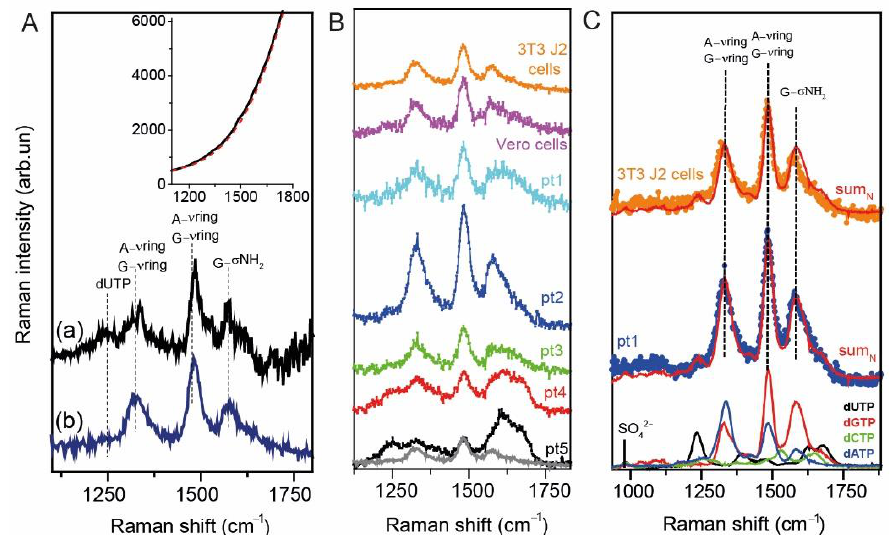
Figure 1. UV-Vis spectra of RNA extracted from 3T3 J2 and Vero E6 cells and from the semen of 5 patients. Vertical dashed black lines indicate the peaks arisen from the presence of proteins and phenolic compounds (i.e., Trizol) in the final eluates.